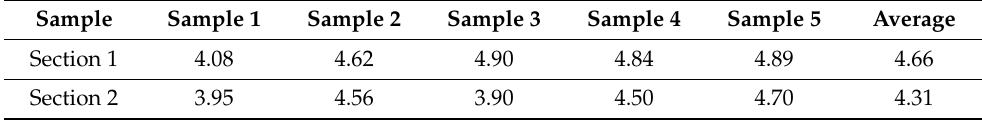
Table 1. Measured axial effective thermal conductivity.